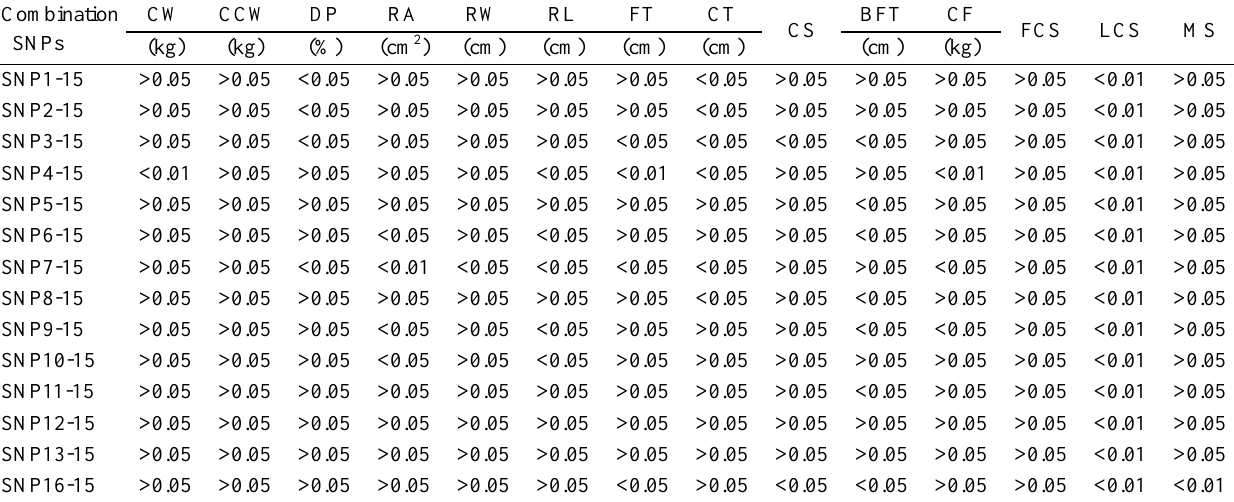
Table 5. p Values of the effects of the combination genotypes on beef quality traits in Snow Dragon beef